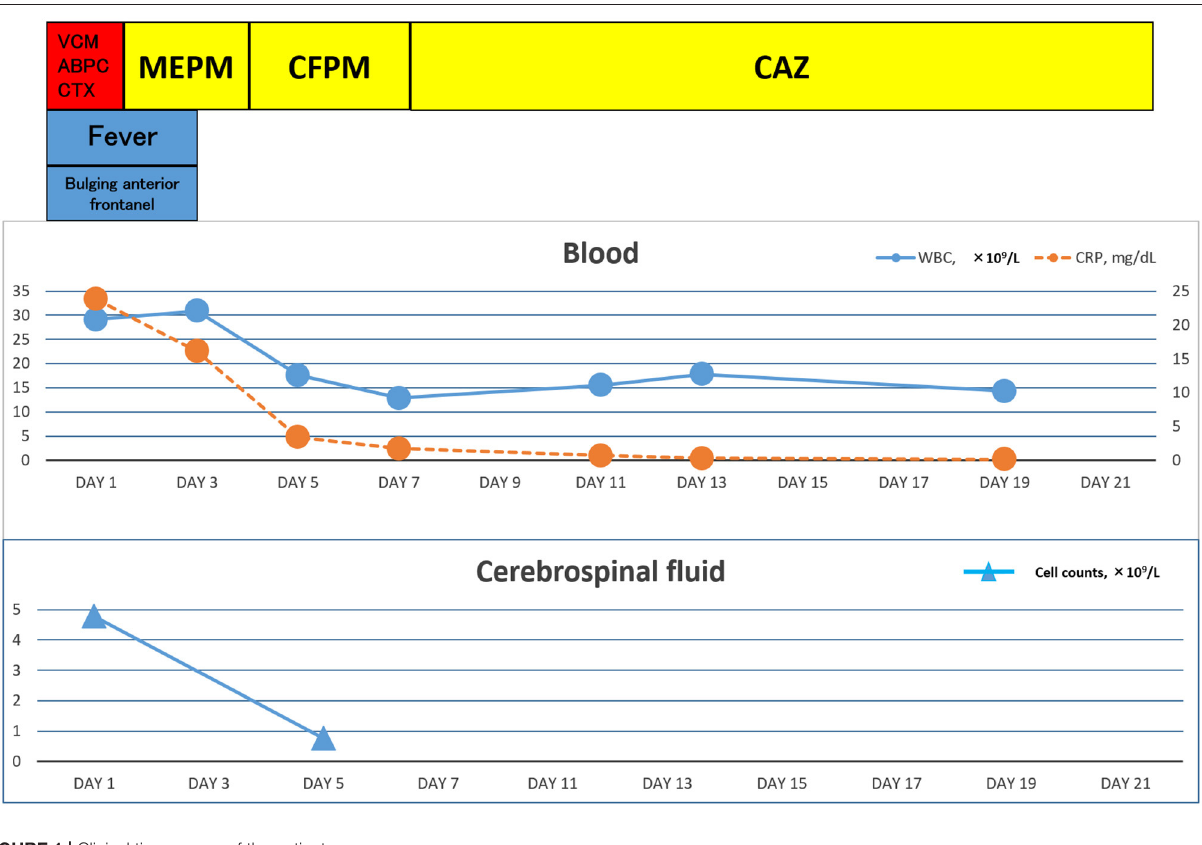
FIGURE 1 | Clinical time course of the patient.